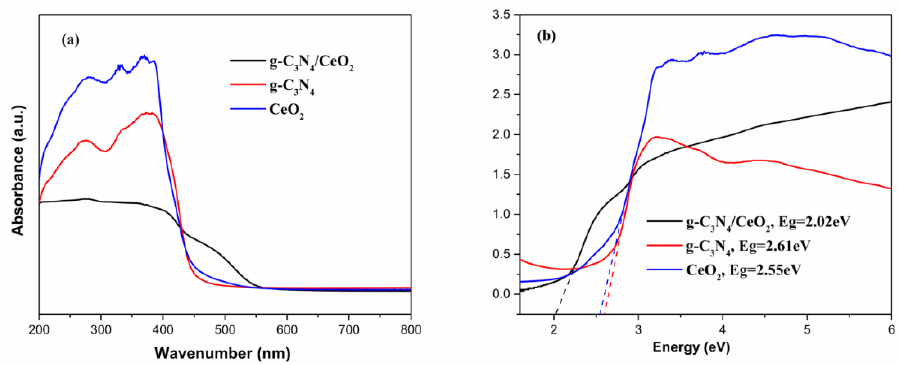
Figure 5. ( a ) UV-Vis DRS, ( b ) plots of ( α h ν ) 1/2 vs. photon energy of g-C 3 N 4 , CeO 2 , g-C 3 N 4 /CeO 2 samples.